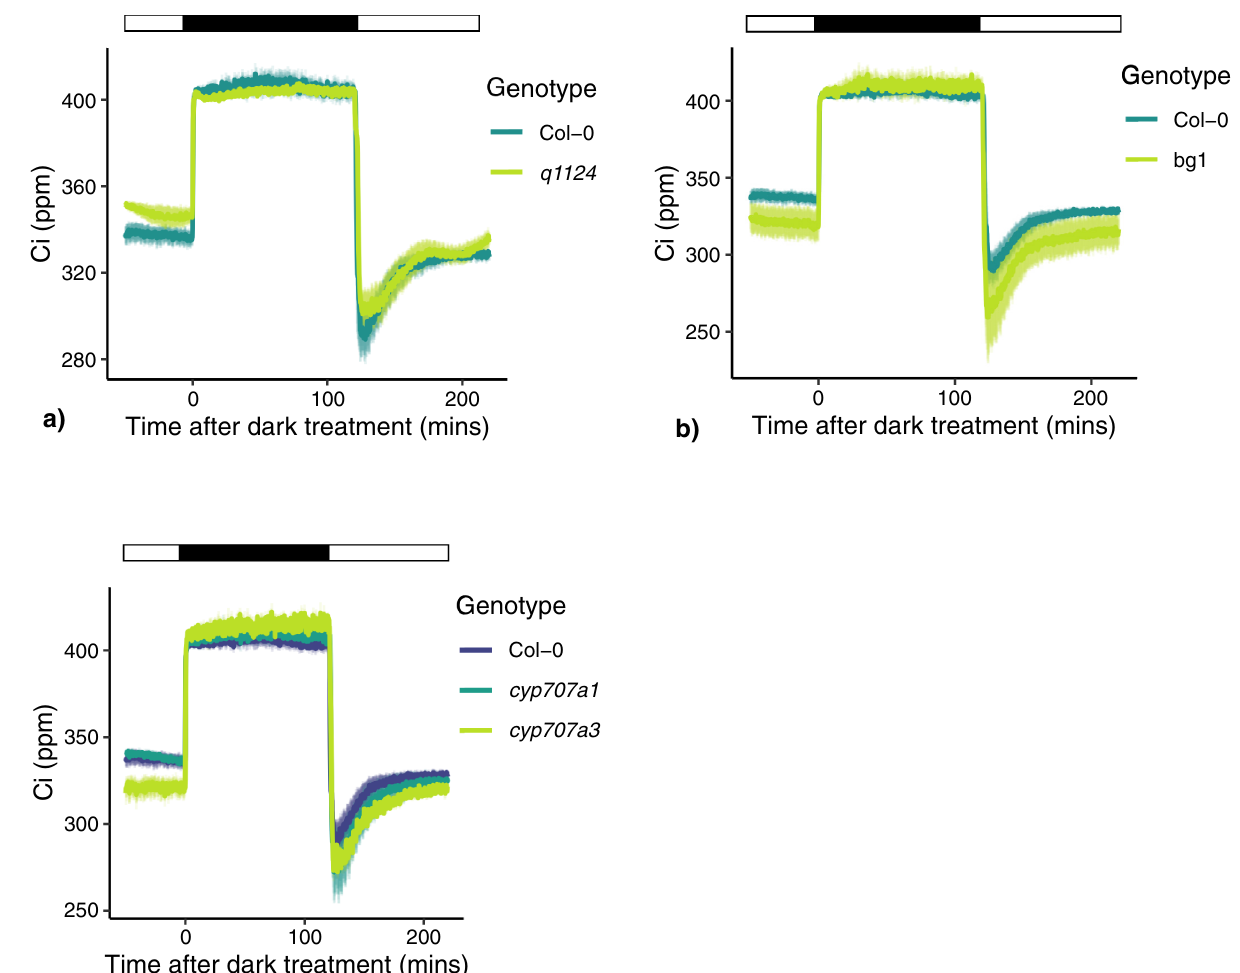
Figure 3. Intercellular CO 2 concentration in response to darkness applied at midday. Intercellular CO 2 concentration (C i ) of leaves of ( a ) ABA receptor mutant ( q1124 ), ( b ) ABA activation mutant ( bg1 ), ( c ) ABA degradation mutants ( cyp707a1 and cyp707a3 ) in response to darkness applied at midday. Lines represent the mean ± s.e.m. 3–4 plants were measured per genotype. Light treatment is represented above each plot, with black boxes representing darkness and white boxes representing